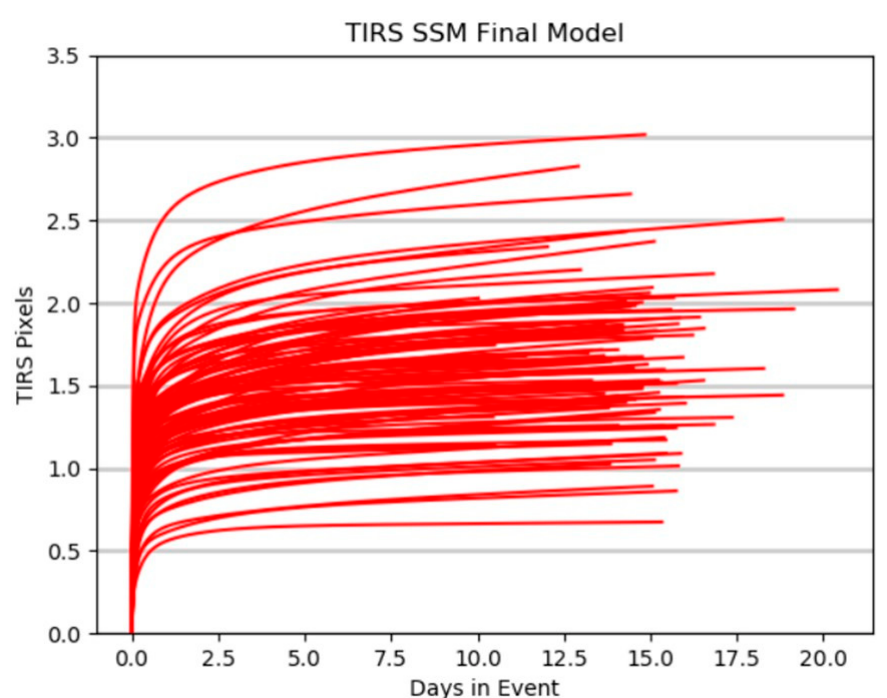
Figure 6. SSM models from 1 March 2016 to 11 May 2020plotted relative to a start time and date of zero. The length of each plot shows the variability in the length of each event. Variability in the shape of each model is evident, as is the flattening out of the profile as the mirror’s behavior stabilizes farther from the start of the event.